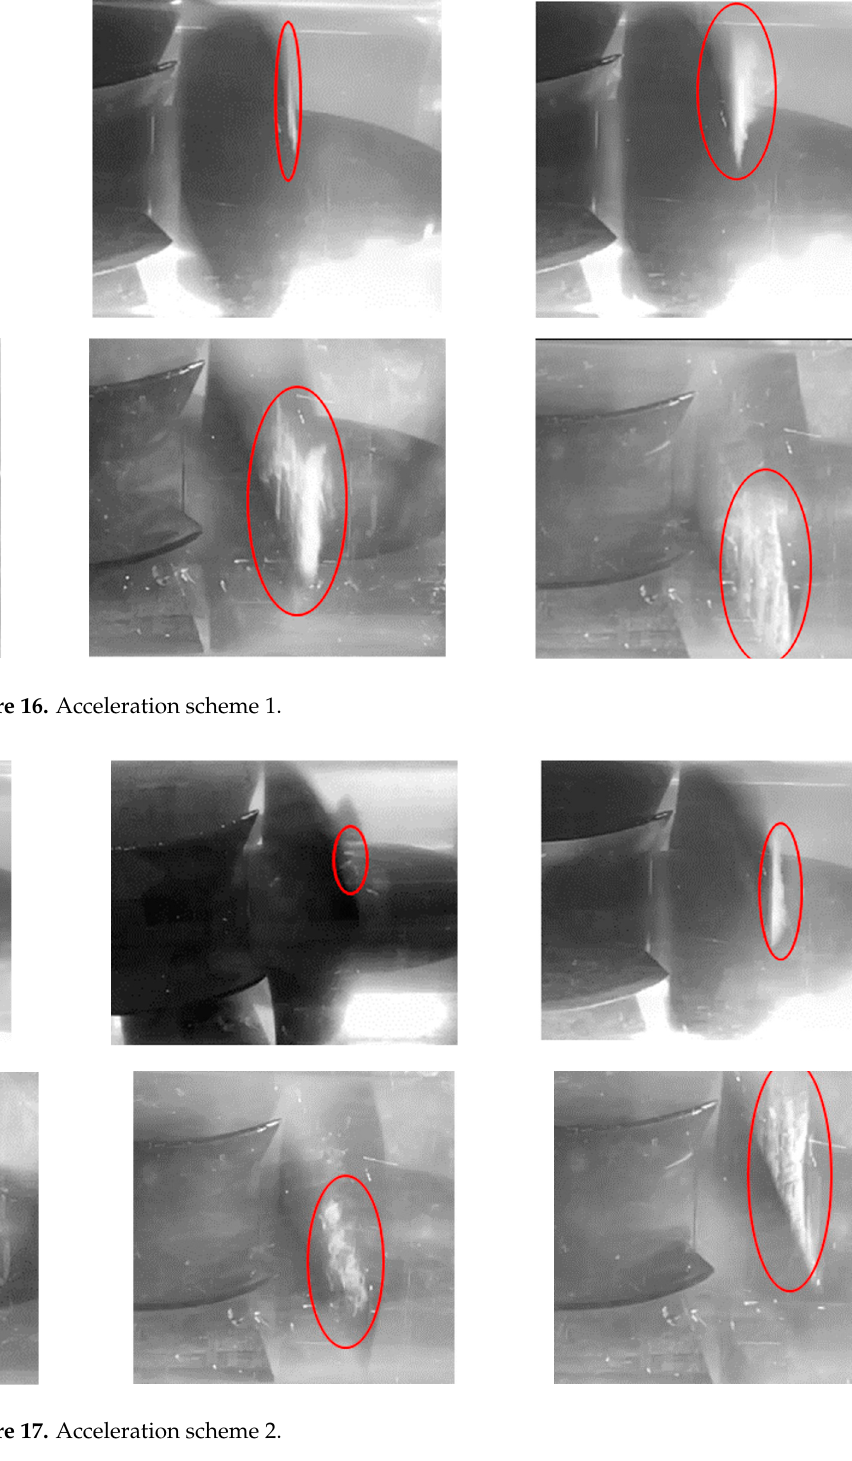
Figure 18. Acceleration scheme 3. The cavitation visualization experiment shows that cavitation occurs at the inlet po- sition of the leaf tip on the back of the blade and extends to the flow path between the blade outlet and the blade as the speed increases. During the acceleration period, a stable, large triangular bubble is formed on the surface of the blade, and the pump unit vibrates violently. During the acceleration process, the cavitation performance of the test pump is controlled by speed and acceleration. The cavitation degree of the test pump under uni- form acceleration increases slowly with time, while the cavitation of the test pump under constant acceleration changes dramatically. However, no matter which frequency conver- sion method is used, the cavitation phenomenon will occur after the acceleration, which will affect the performance of the pump. For a pump that needs frequency conversion for a long time, the inlet pressure should be increased as much as possible to restrain cavita- tion. 5. Conclusions Based on a method combining numerical simulations and experiments, this paper studied the evolution of the cavitation of an axial-flow pump and the influence of cavita- tion on pressure under VVVF, and finally drew the following conclusions: